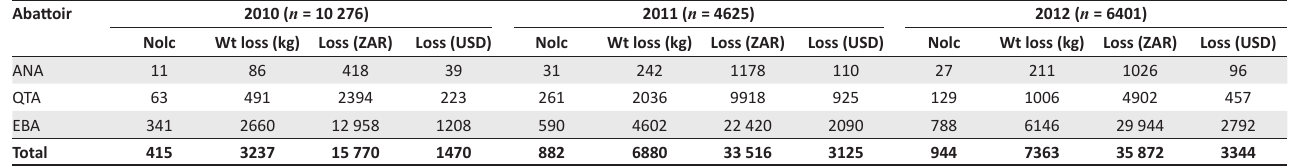
TABLE 1: Losses associated with lung condemnation in three abattoirs from 2010 to 2012.